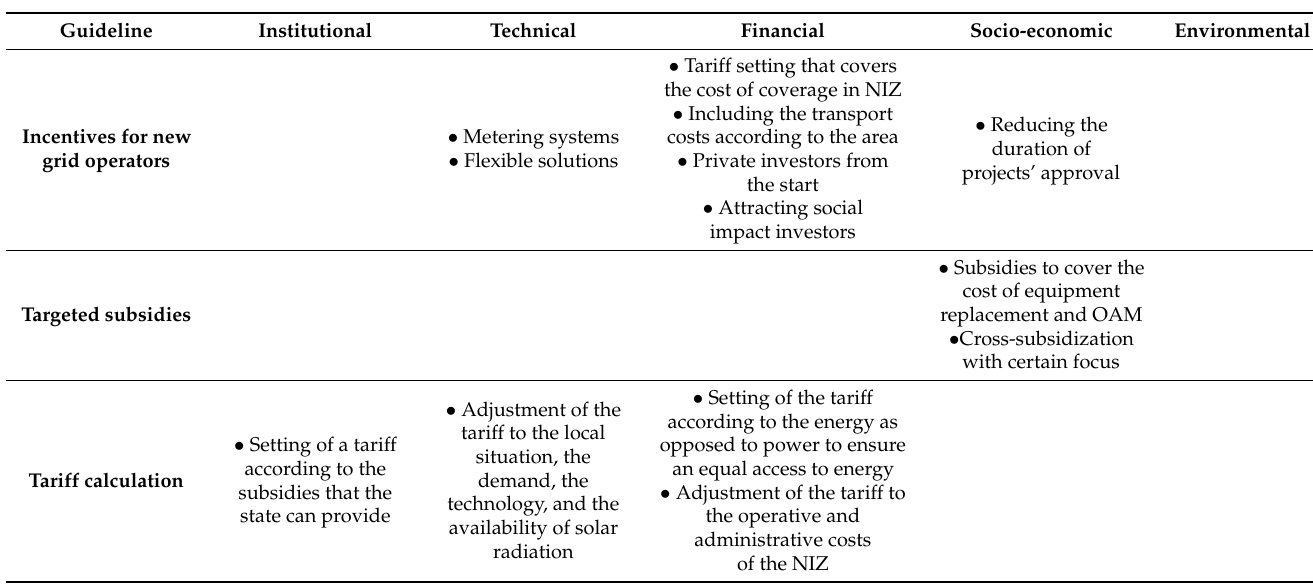
Table 5. Guidelines for financial